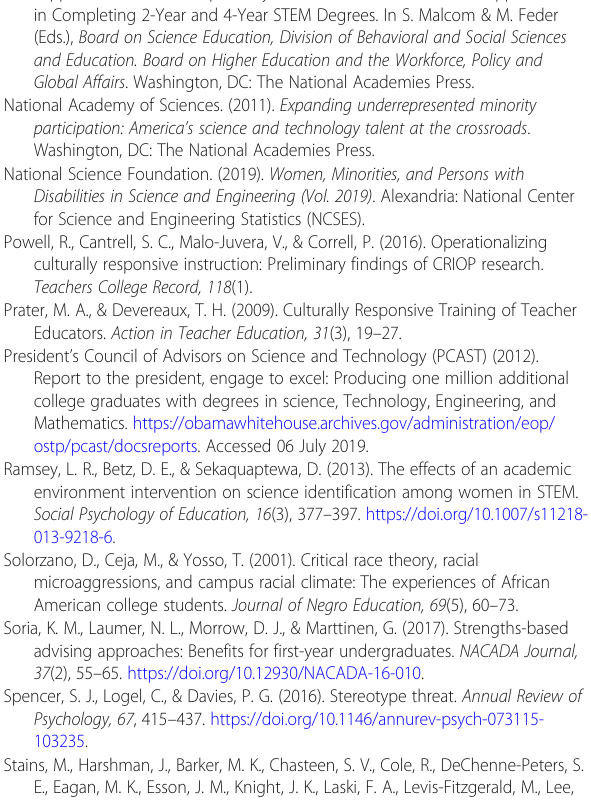
table/US/PST045216. Accessed 04 Aug 2019. U.S. Department of Education, National Center for Education Statistics